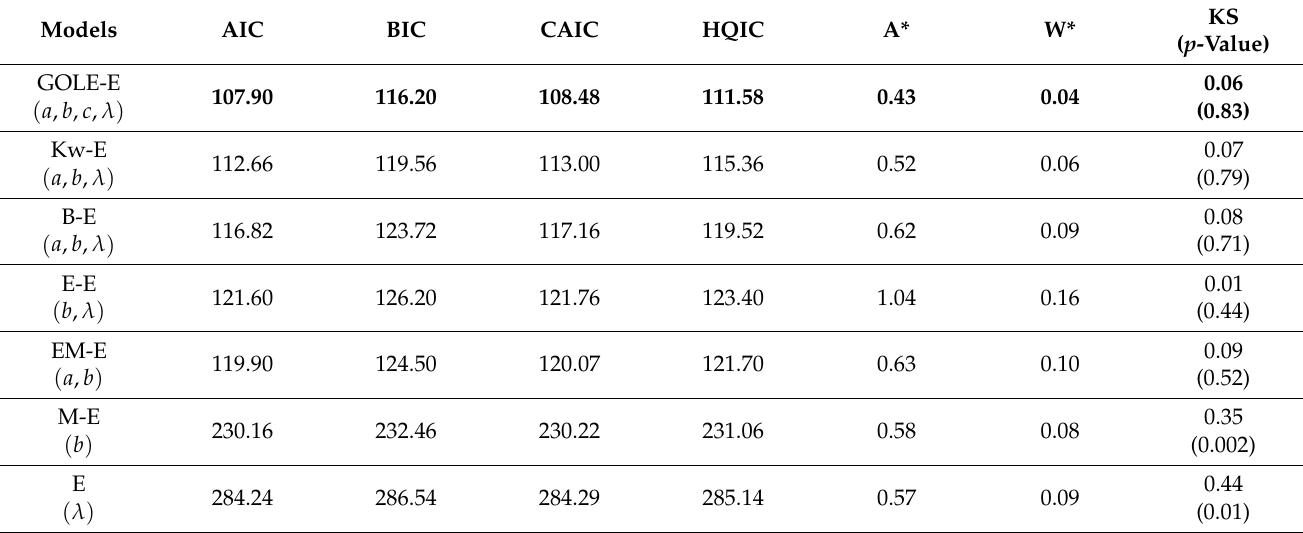
Table 6. The AIC, BIC, CAIC, HQIC, A*, W* and KS ( p -value) values for data set